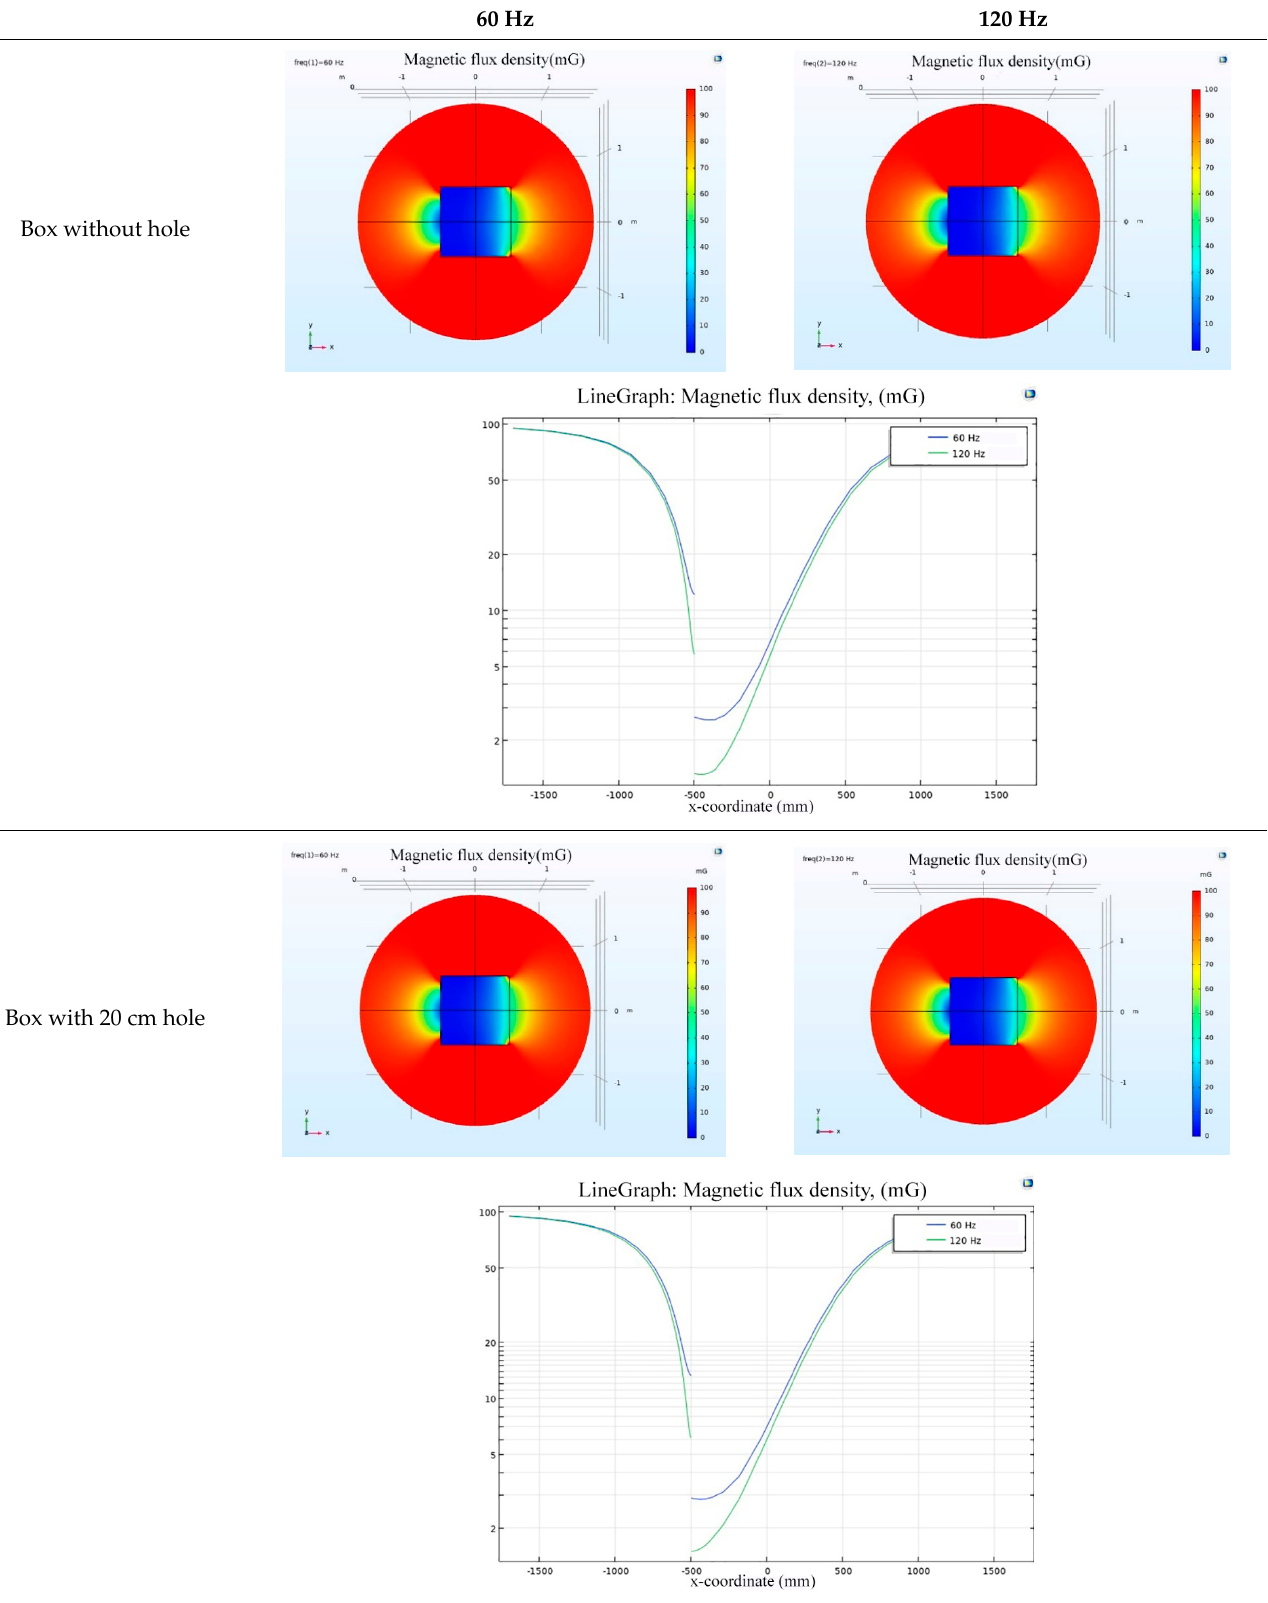
Table 4. Shielding capability of the MSR for the different hole patterns with the corresponding magnetic flux density graph. 60 Hz